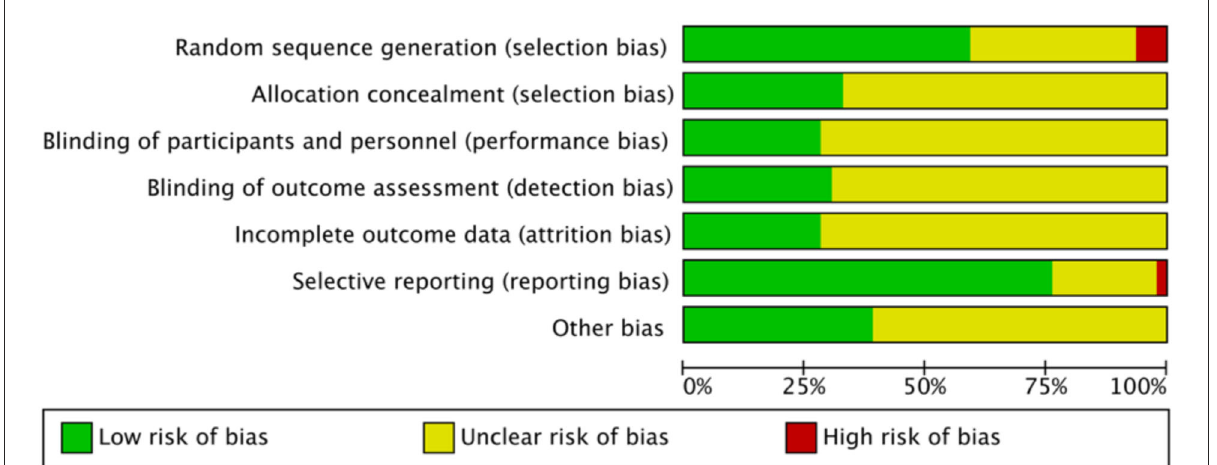
FIGURE2 Risk of bias summery for 46 included studies.